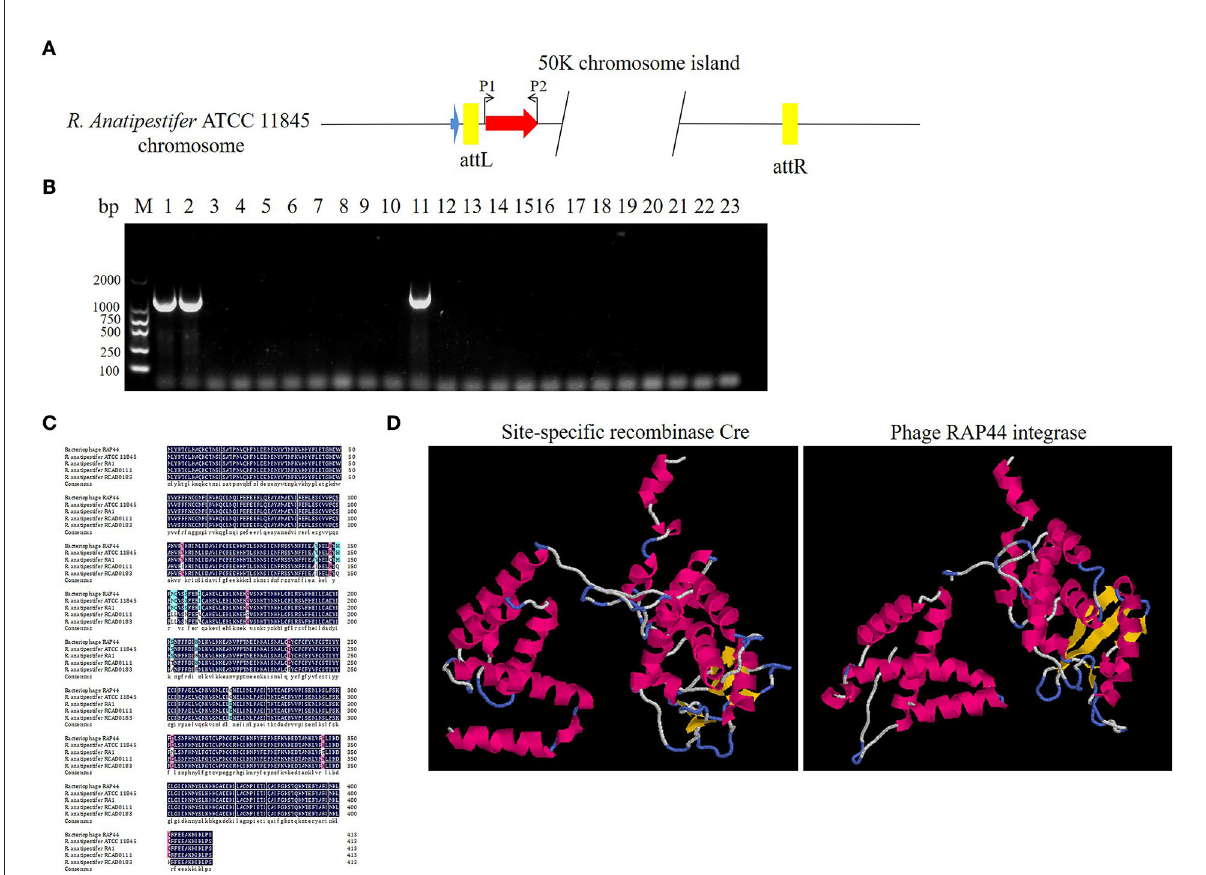
FIGURE4 Analysis of RAP44 integrase and genomic island in R. anatipestifer . (A) Integrase gene with P1/P2 primer pairs was detected in R. anatipestifer ATCC 11845, RA-YM, and 20 R. anatipestifer clinical isolated strains. (B) Detecting of integrase in R. anatipestifer clinical isolated strain with primer pair P1/P2. Lane 1: R. anatipestifer ATCC11845 strain; lane 2, R. anatipestifer YM strain; lanes 3–22: 20 clinical isolated strains no. 1–20; lane 23: negative control; ATCC 11845, RA-YM, and clinical isolated strain no. 9 with the integrase. (C) Sequence alignment analysis shows that the integrase was tyrosine integrase and highly conserved in R. anatipestifer . (D) Phyre 2 was applied to predict the integrase protein 3D structure. We found that the integrase protein structure is similar to tyrosine recombinase